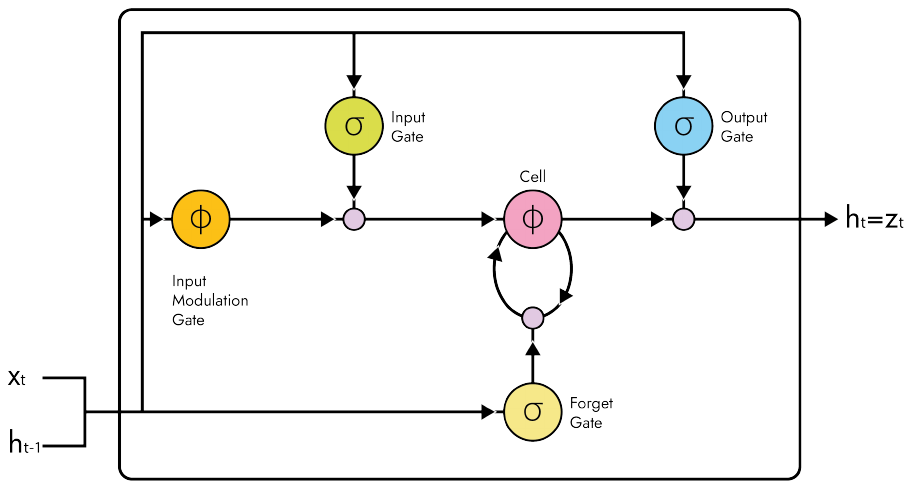
Figure 2. Long short-term memory